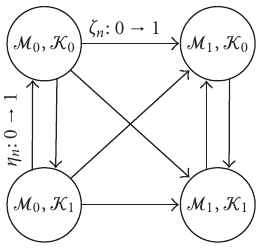
Figure 1: Transitions among regime